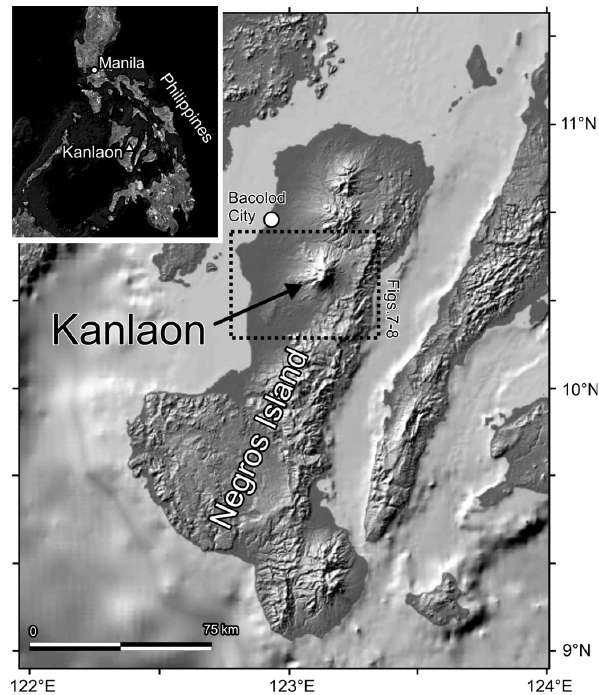
Fig. 3. Location of the study